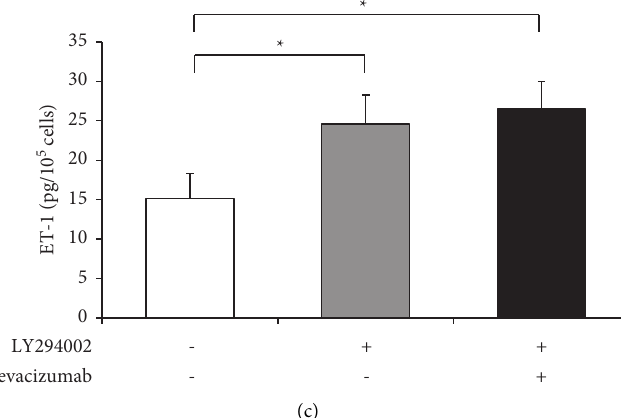
Figure 2: The Akt pathway was inactivated in human glomerular microvascular endothelial cells (hGECs) treated with bevacizumab. hGECs were plated in 24-well plates (1 × 10 5 cells/well) for ELISA or 60 mm culture dishes (1 × 10 6 cells/dish) for RT-PCR and western blot. hGECs that were 90% confluent were serum-starved for 24 h before the experiments were performed. hGECs were treated with 1 µ M bevacizumab or 10 µ M LY294002 (PI3K/Akt inhibitor) for 8h, and western blots were used to evaluate the changes in Akt phosphorylation after bevacizumab treatment (a). The levels of ET-1 mRNA (b) and ET-1 protein (c) were measured using real-time RT-PCR and the ELISA after LY294002 treatment. Data shown are means ± SD ( n � 3; ∗ p < 0.05). The experiments were repeated at least three times, with reproducible